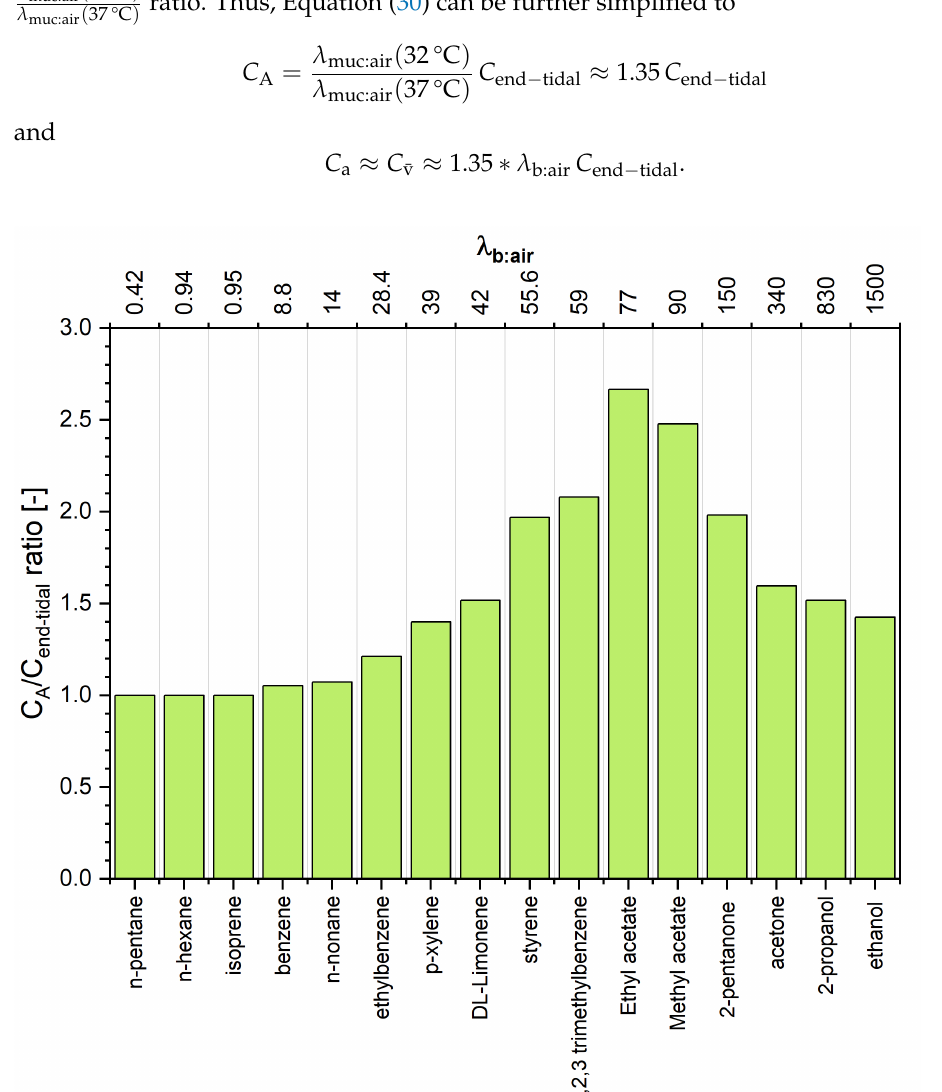
tidal for VOCs under −